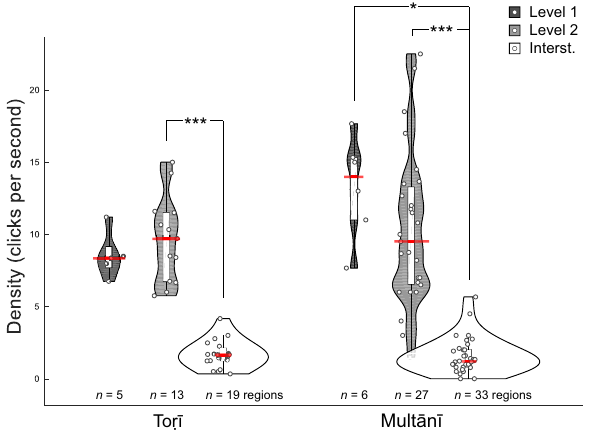
Figure 2. Click densities for each rāga. Dots represent time regions (cf Fig. 1C) and clicks are counted across all participants. Violin plots show click density distributions across all 3 region types: Level 1 (dark grey), Level 2 (light grey) and interstitial (white), extending to the lowest and highest data points in each distribution. Within them are Tukey boxplots, with boxes (white background) drawn between the 1st and 3rd quartiles, representing the IQR (interquartile range), and whiskers extending to ± 1.5 IQR of the box. Red lines indicate medians. As in the remaining figures, asterisks denote level of significance (* p < 0.05; ** p < 0.01; *** p < 0.001).